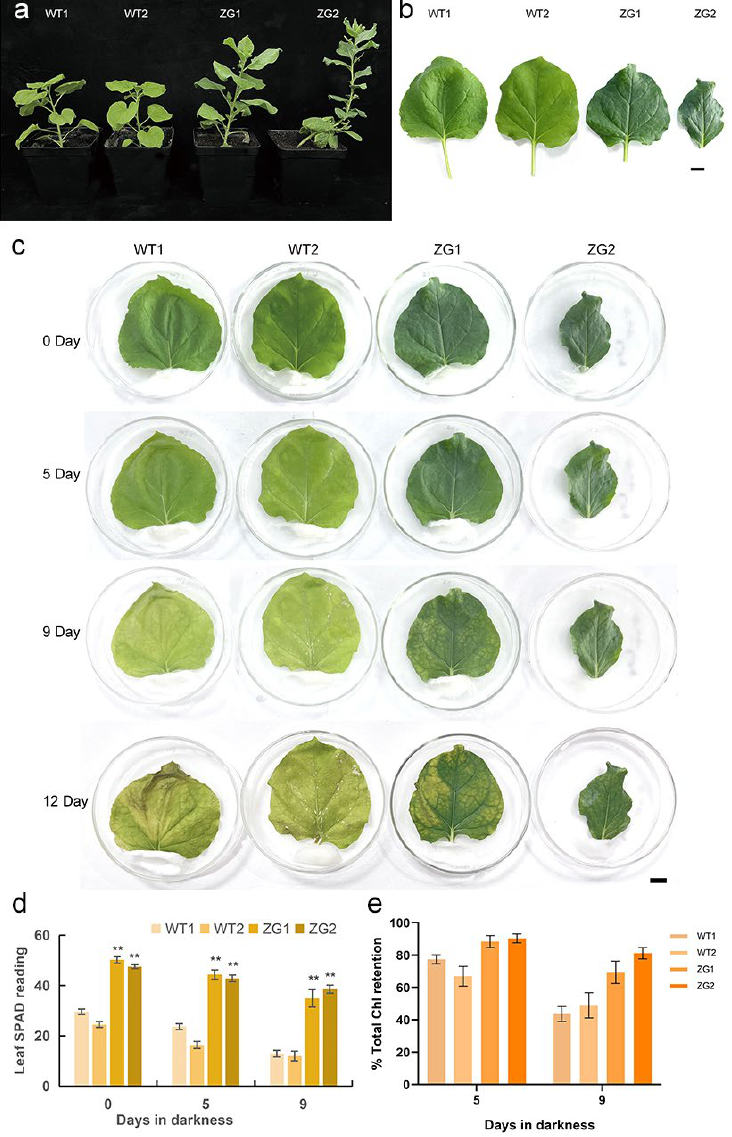
Figure 9. Phynotypic difference of WT and transgenic N. benthamiana overexpressing ZaGRF6 Figure 9. Plant phenotype of WT and transgenic Nicotiana benthamiana overexpressing ZaGRF6 . De- layed senescence of excised leaves of transgenic Nicotiana benthamiana expressing ZaGRF6 . ( a ) Plant architecture; ( b ) leaf phenotype; ( c ) excised leaves were incubated in darkness for 0, 5, 9, and 12 days; ( d ) the chlorophyll content of leaves of transgenic and WT plants incubated in darkness for 0, 5, and 9 days; ( e ) total chlorophyll retention of leaves of transgenic and WT plants after 5 and 9 days incubated in darkness. The error bars represent the standard error of the means of three independ- ent replicates of qRT-PCR analysis. p values were determined according to one-factor ANOVA test (** p < 0.01) ( n = 10).